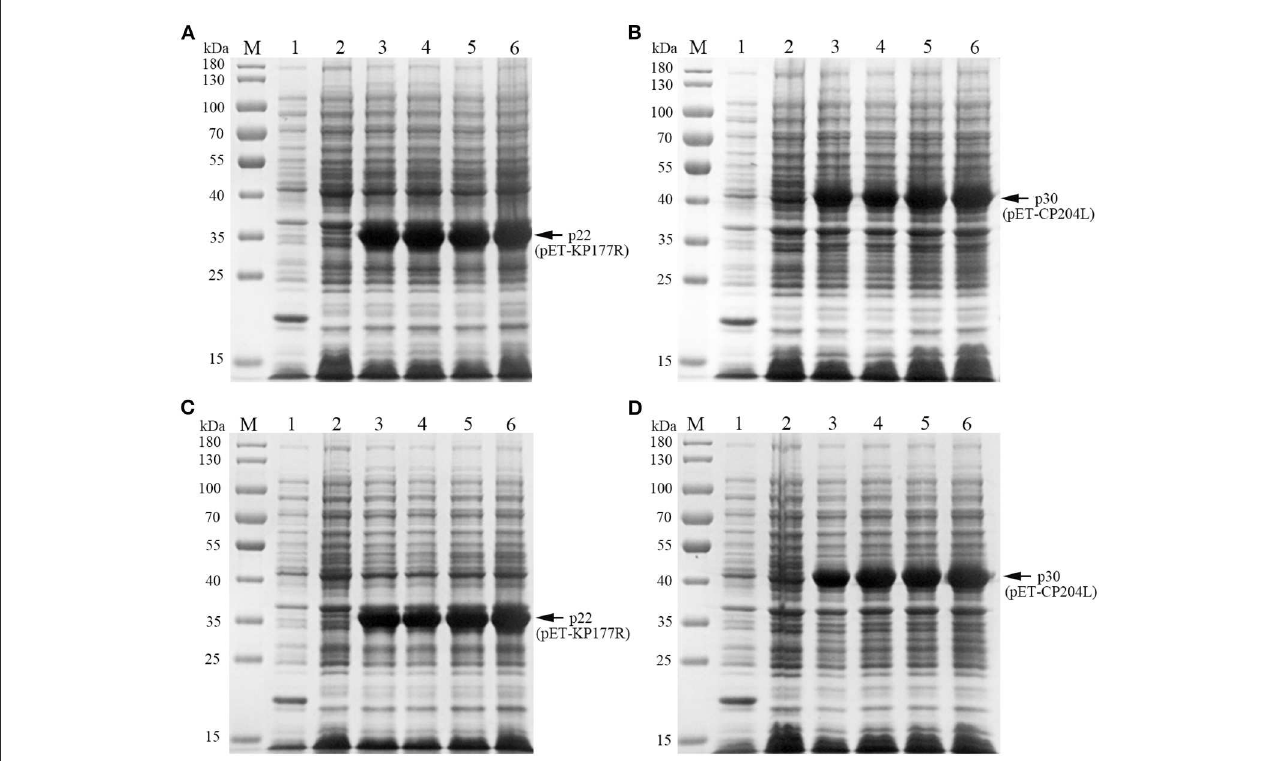
FIGURE1 Exploration of p22 and p30 proteins induction conditions. (A, B) Determination of optimal IPTG concentration of p22 (A) and p30 (B) . M, Marker; (1) pET-32a empty carrier; (2) Before induction; (3–6) IPTG concentration at 0.1, 0.4, 0.7, and 1.0mM. (C, D) Determination of the best OD 600 of p22 (C) and p30 (D) . M, Marker; (1) pET-32a empty carrier; (2) Before induction; (3–6) OD 600 at 0.4, 0.6, 0.8,